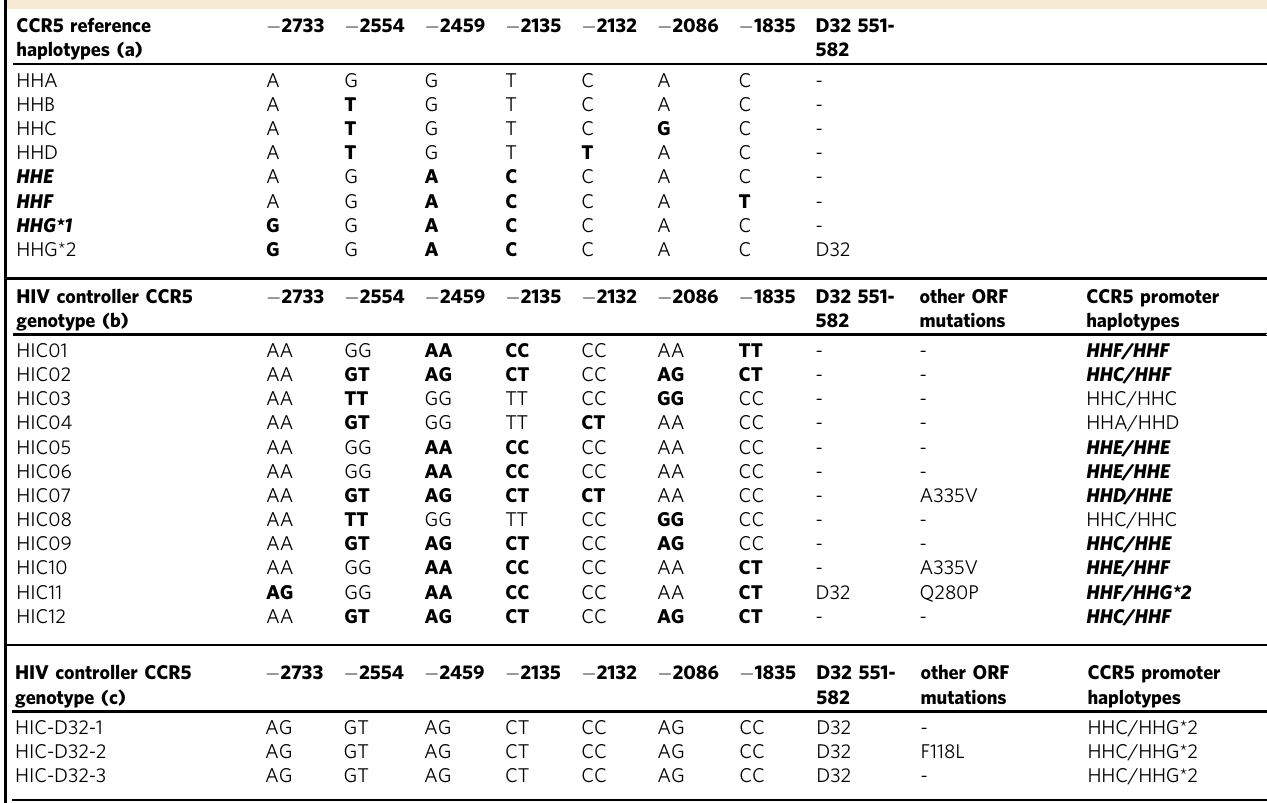
(a) List of CCR5 promoter haplotypes as de fi ned by Mummidi et al. (J Biol Chem 275:18946, 2000). Nucleotide changes compared to the reference haplotype HHA are in bold. The names of deleterious haplotypes associated with high CCR5 expression are in bold italics. (b) The whole CCR5 locus (9kb) was sequenced by PacBio long-read technology for the 12 HIV controllers included in the MHCII tetramer study, except for HIC09, for whom the CCR5 locus was sequenced by the Sanger method except for HIC09, for whom the CCR5 locus was sequenced by the Sanger method. (c) Analysis of the CCR5 locus in 3 HIV controllers carrying the D32 mutation and showing low CCR5